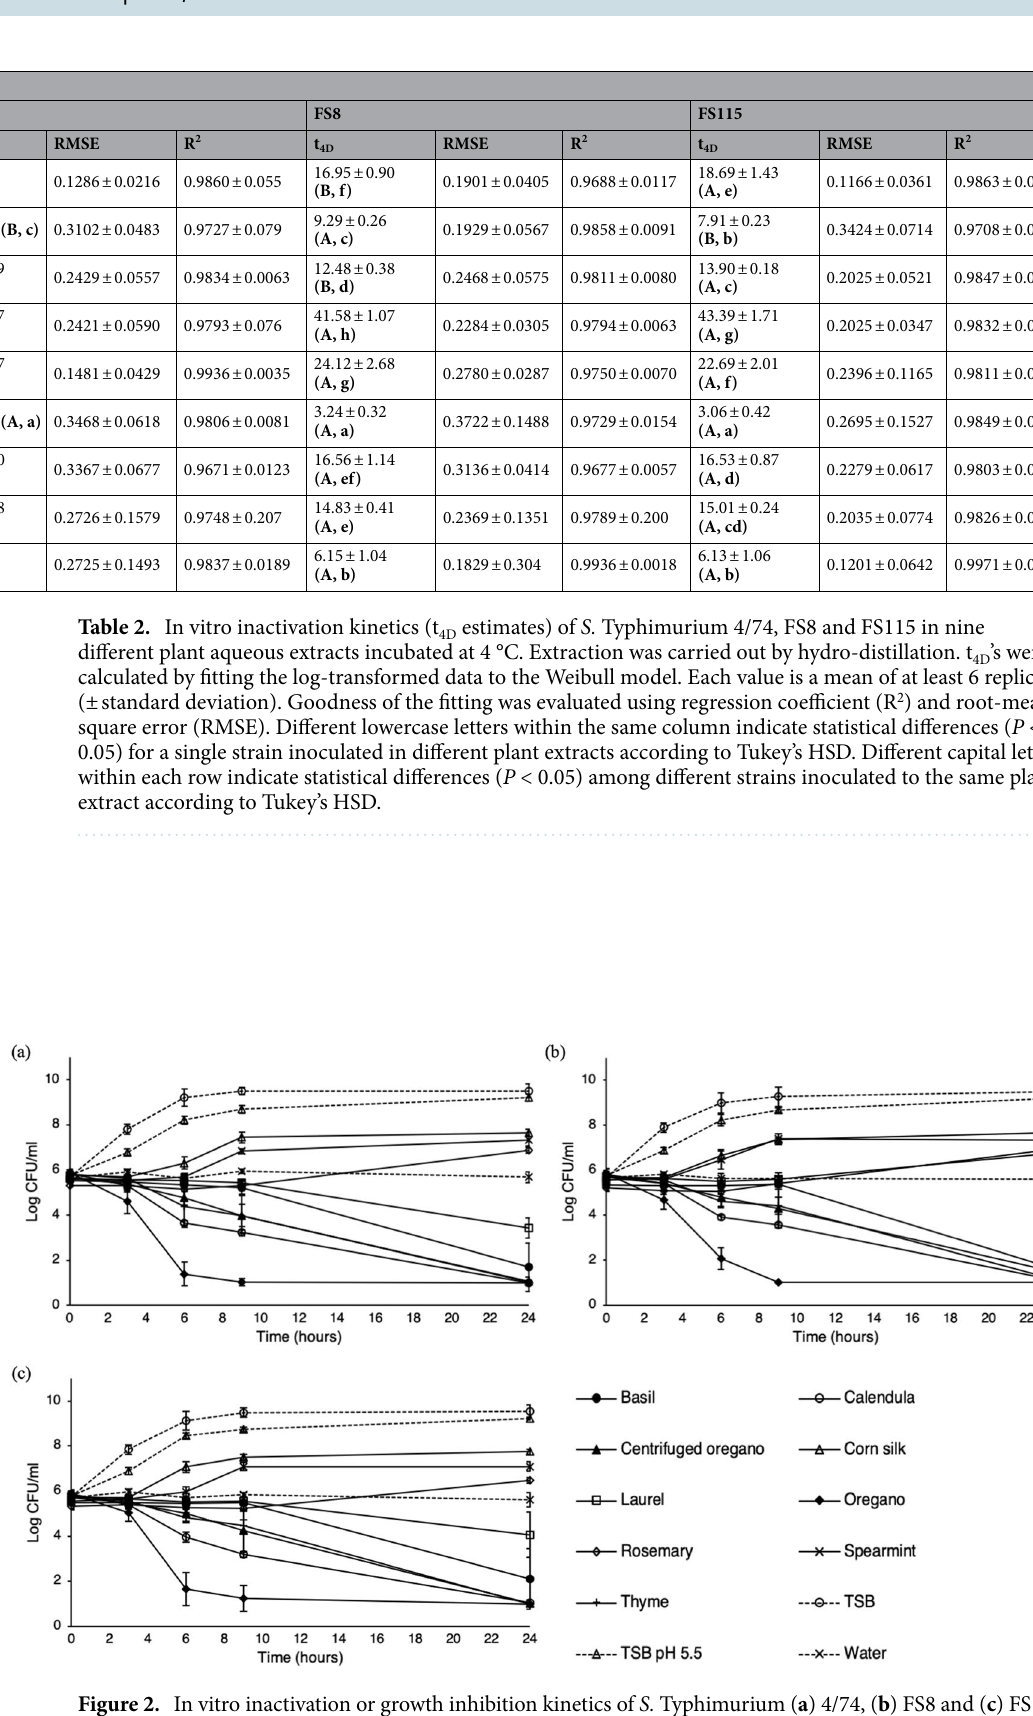
Figure 2. In vitro inactivation or growth inhibition kinetics of S. Typhimurium ( a ) 4/74, ( b ) FS8 and ( c ) FS115 in nine different plant aqueous extracts incubated at 37 °C. Extraction was carried out by hydro-distillation. TSB, TSB adjusted to pH 5.5 and de-ionized water were used as controls. Each data point is a mean of at least 6 replicates (± standard